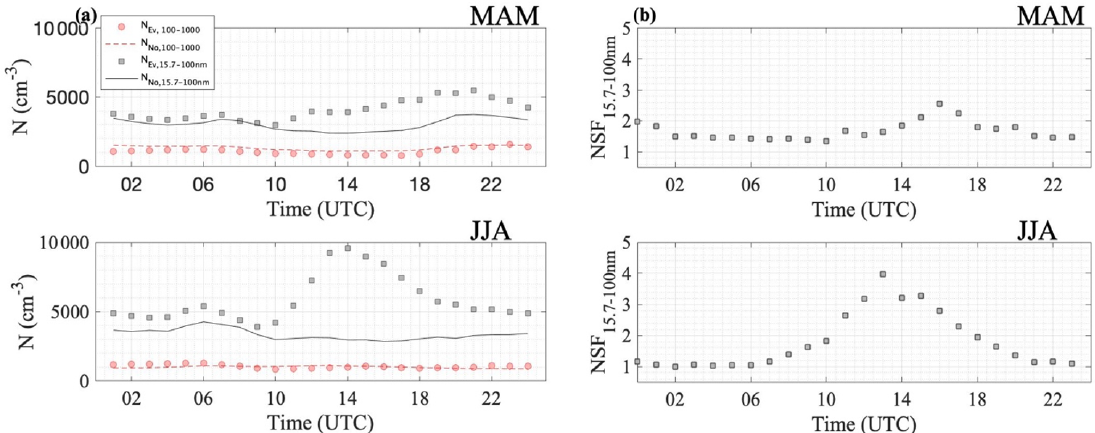
Figure 11. (a) Diel variations of fine (15 . 7 < D p < 100nm) and accumulation (100 < D p < 1000nm) mode particle number concentrations ( N 15 . 7–100 in black and N 100 − 1000 in red) during MAM and JJA at the ATOLL site during the 2017–2020 period. The dots correspond to NPF event days, while the line correspond to non-event days. (b) Diel variations of the nucleation strength factor (NSF 15 . 7–100 ) for each season calculated from N 15 . 7–100 and N 100 − 800 observed during the 2017–2020